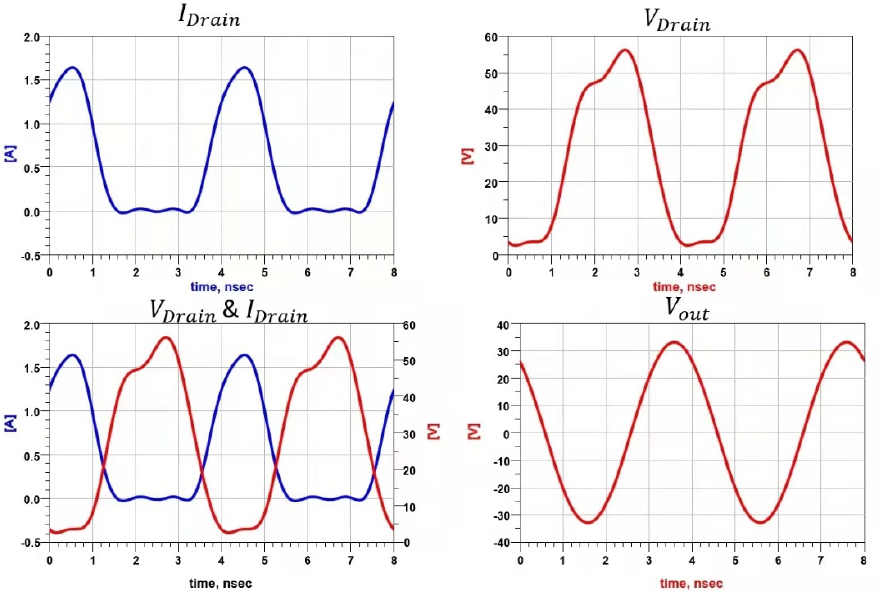
Figure 23. The voltage and current waveforms of the transistor drain and of the output (antenna).